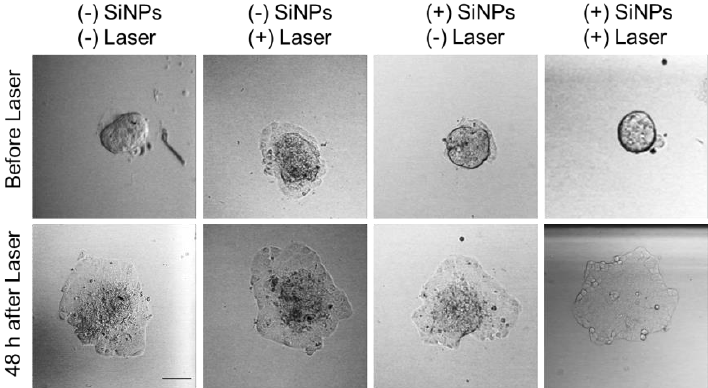
Figure 5. Two-photon excitation PDT effect of SiNPs on 3D cultures. Spheroids from MCF-7 cells were treated or not with 50 µg mL −1 of SiNPs for 24 h and irradiated or not with pulsed laser at 900 nm (3 scans × 1.57 s). Pictures are representative of the whole. Scale bar: 100 µm.